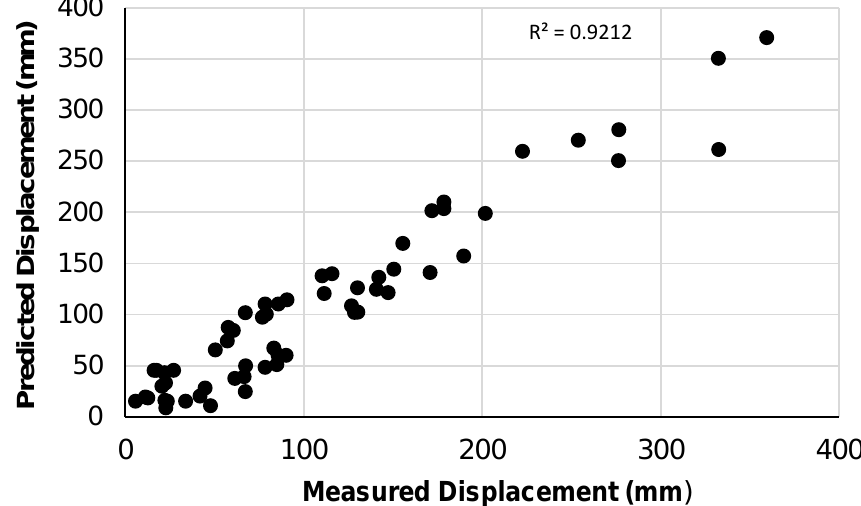
Fig. 4. Correlation between output and target values for test data.